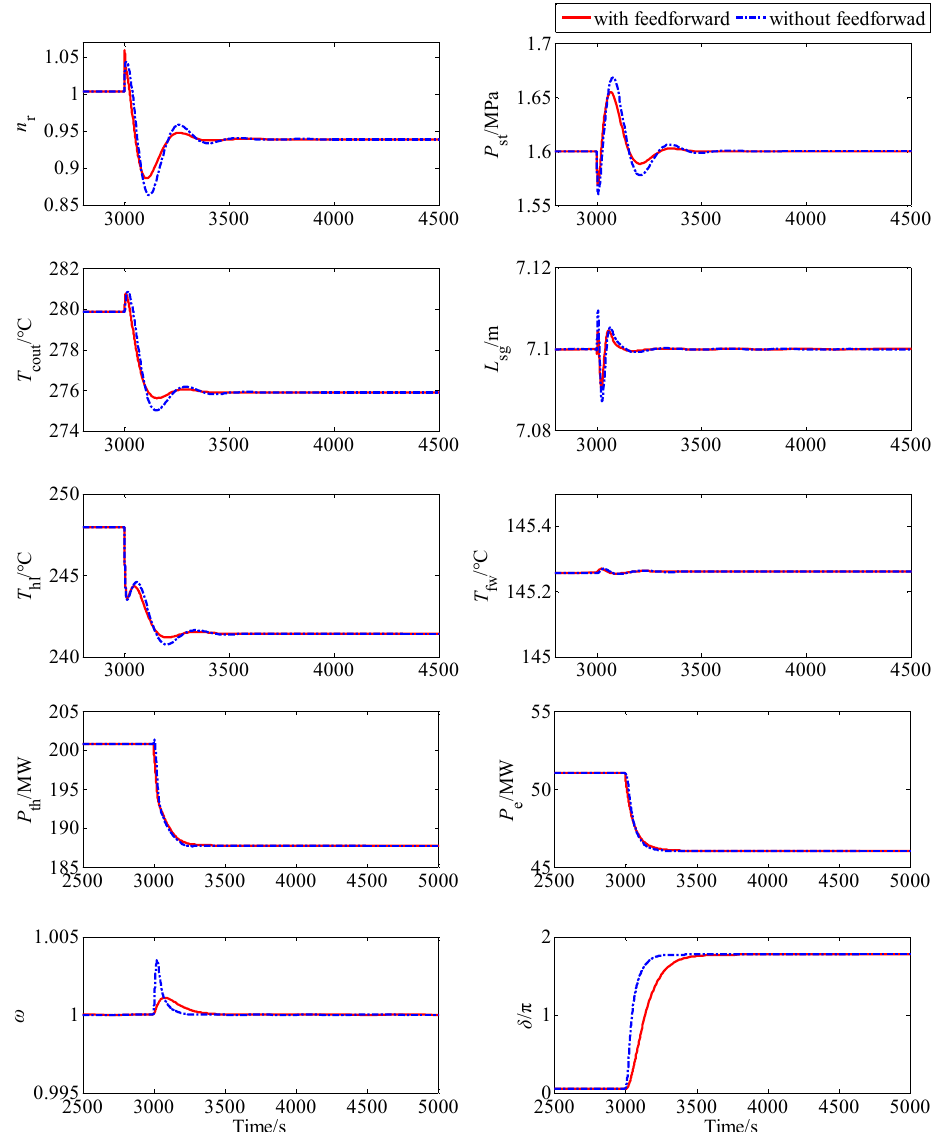
Figure 6. Responses of key process variables in the case of load stepping, n r : neutron flux, T cout : core outlet temperature, T hl : IC hot leg temperature, P st : live steam pressure, L sg : UTSG water-level, T fw : feedwater temperature, P th : thermal power, P e : electric power, ω : normalized frequency, and δ : phase angle.